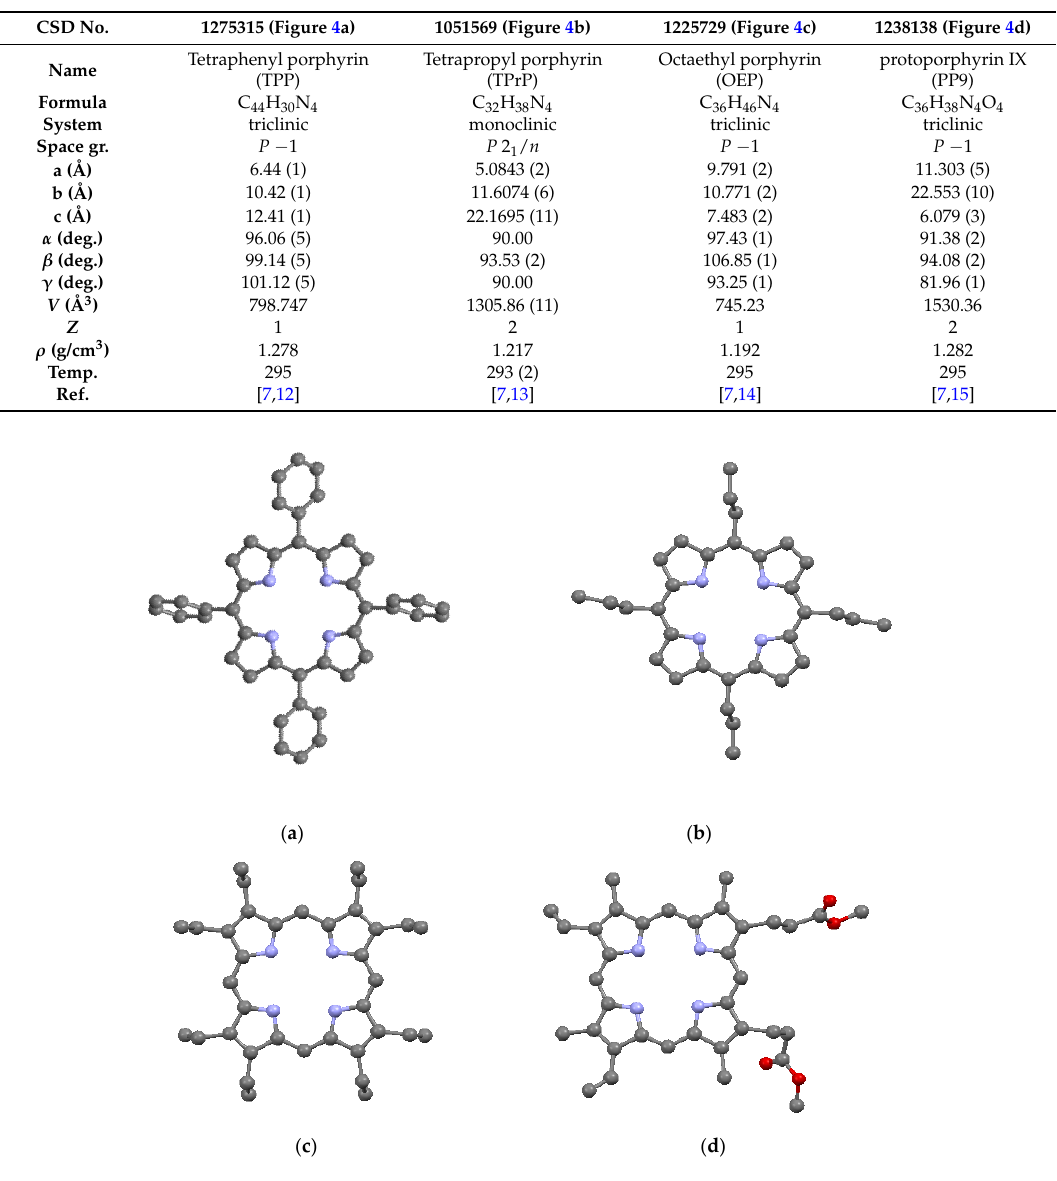
Figure 4. Examples of substituents: ( a ) TPP; ( b ) TPrP; ( c ) OEP; and ( d ) PP9; from data of [7,12–15]. Shown without hydrogens. Red = O.